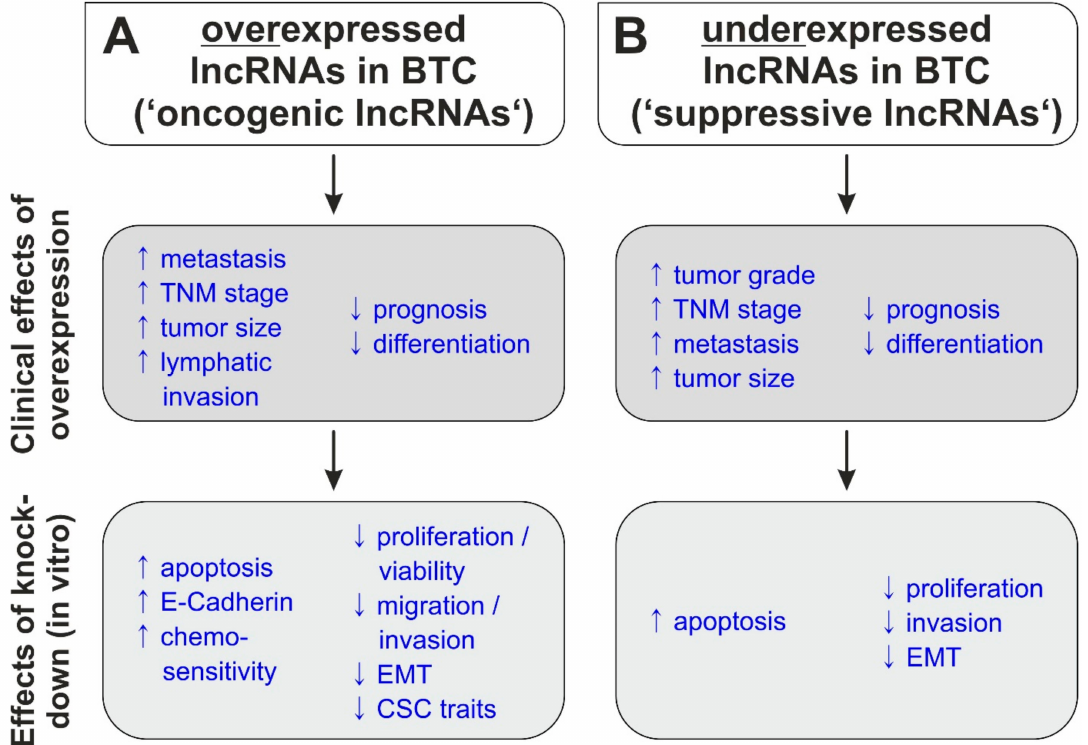
Figure 2. ( A ) Overexpression of oncogenic lncRNAs in BTC patient specimens is associated with unfavorable clinical characteristics. Knockdown of oncogenic lncRNAs in BTC in vitro models results in reduction of oncogenic characteristics and initiation of apoptosis, E-Cadherin expression and enhanced chemosensitivity. ( B ) Under-expression of suppressive lncRNAs in BTC patient specimens is associated with unfavorable clinical characteristics. Artificial overexpression of suppressive lncRNAs in BTC in vitro models reduced BTC cell proliferation, invasion and EMT characteristics and induced apoptosis. Abbreviations: BTC: biliary tract cancer; EMT: epithelial-to-mesenchymal transition; lncRNA: long-noncoding